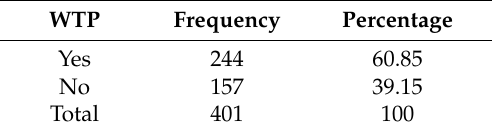
Table 5. Households’ willingness to pay for improved waste collection